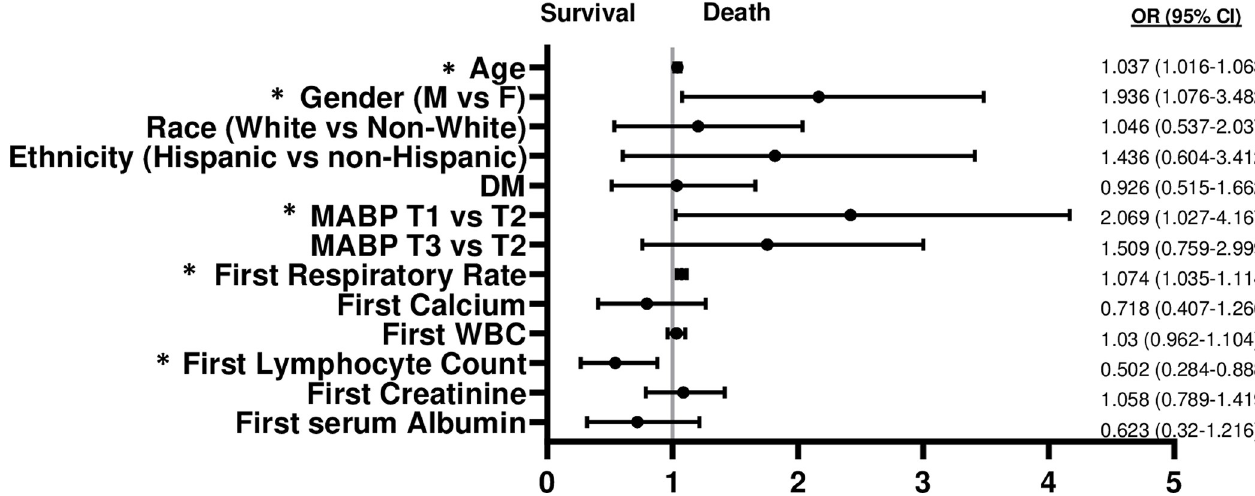
Fig 2. The OR of variables that predict mortality in subjects with a history of HTN and hospitalized with COVID-19 (+).